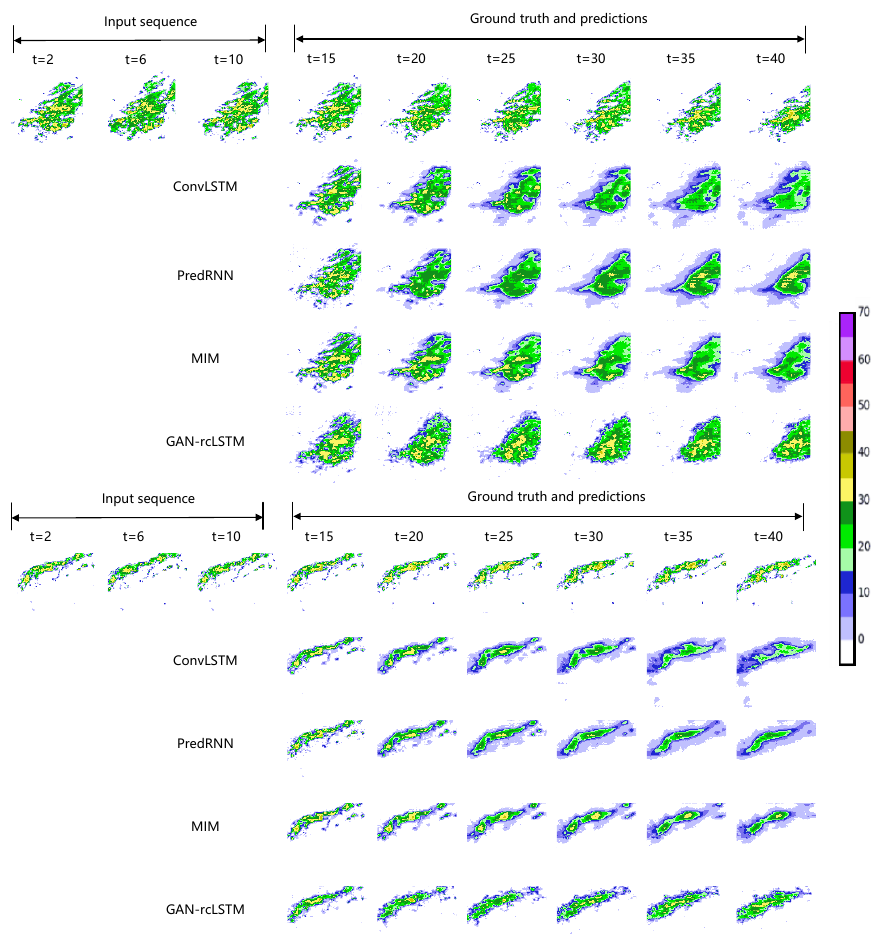
Figure 7. Examples of the next three hour predictions at 15:16 on 22 May 2017 and 9:54 on 28 July 2017 in Jiangsu, China. Lines 2–4 are the prediction result of ConvLSTM, PredRNN, MIM, and GAN-rcLSTM for each example. The interval between the displayed predicted images and the input images is 30 min and 24 min, respectively. The radar echo intensity is represented by different colors, in which blue represents 0–15 dbz, green represents 15–30 dbz, and yellow represents 30–40